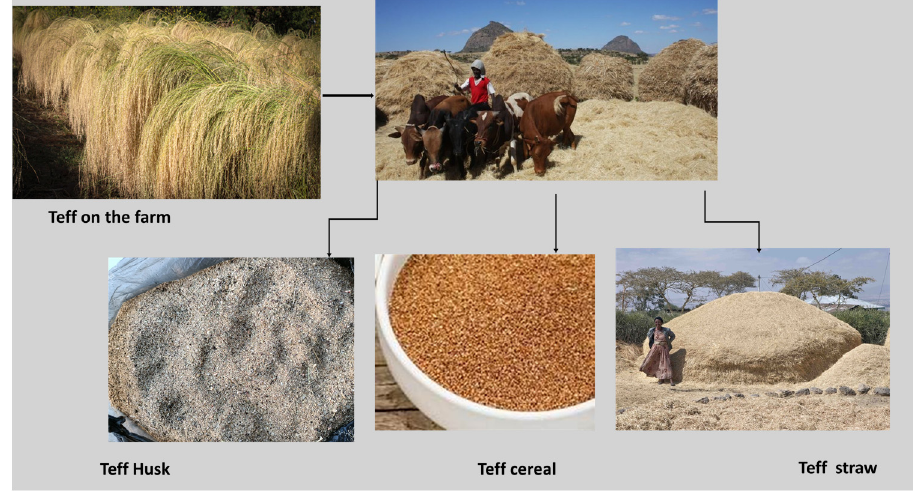
Figure 1. Teff with its residues.